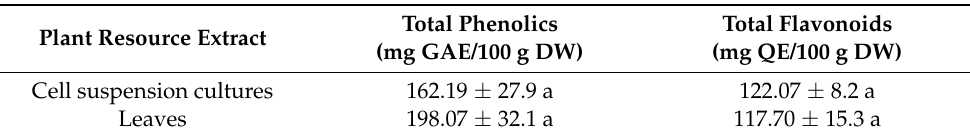
Table 1. Total phenolic and flavonoid contents in methanolic extracts of cell suspension cultures and intact plant leaves from Randia aculeata